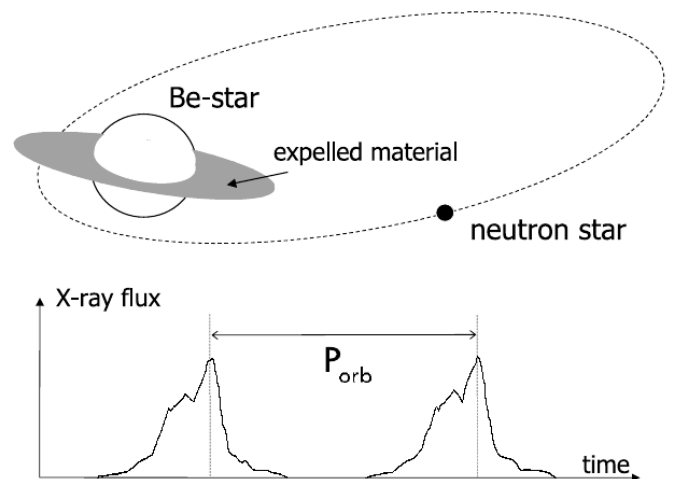
Figure 6. Illustration of a Be X-ray binary. The compact object does not accrete for most of its eccentric orbit as the Be star does not fill its Roche lobe, and the period is too long for wind-fed accretion to take place. At periastron, however, the compact object crosses the circumstellar disk of the Be star and builds up an accretion disk, leading to a burst. Although the example indicates a neutron star, Be star- black hole X-ray binaries can also form. Figure obtained from Tauris and van den Heuvel [108] in Compact Stellar X-ray Sources (Copr. Cambridge University Press 2006), reproduced with permission of Cambridge University Press through